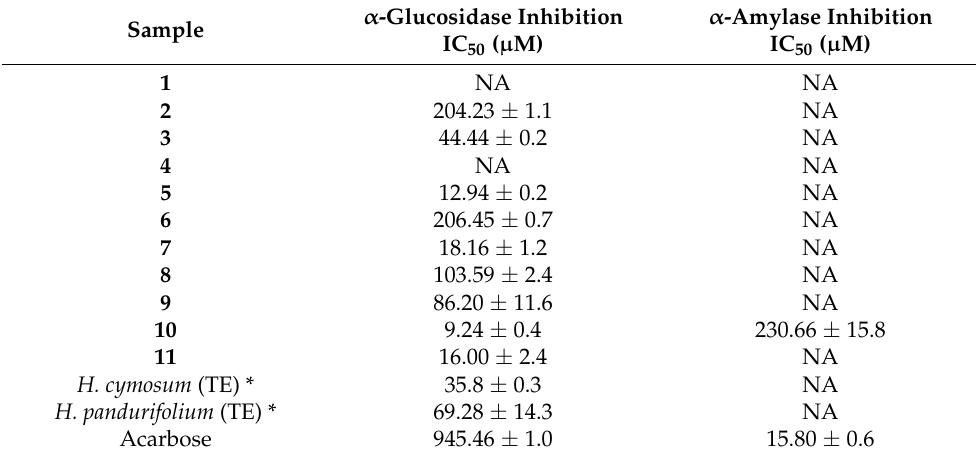
Table 1. Alpha-glucosidase and alpha-amylase Inhibitory activities (IC 50 ) of total extracts and phytochemical constituents of H. cymosum and H. pandurifolium .